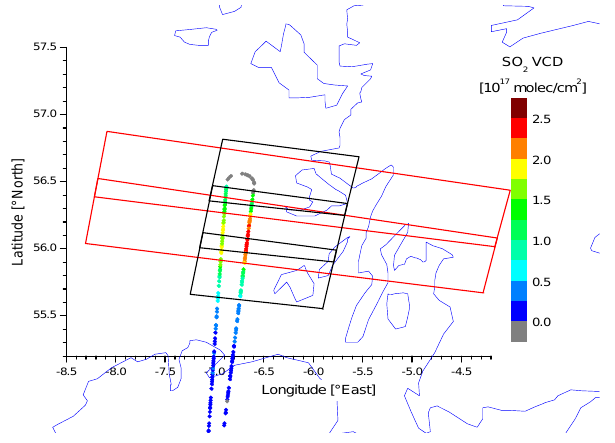
Fig. 14. SO 2 vertical column density from CARIBIC and the ob- served plume position relative to the GOME-2 pixel (black: for- ward, red: back scan). In contrast to Figure 2 only those pixels are shown that cover the volcanic plume and at least one measurement from CARIBIC, namely the pixels 21 of swath 26 (North), 27 and 28, as well as the back scan pixel 27 of swath 26 and 27. The maxi- mum of the CARIBIC DOAS SO 2 columns is perfectly covered by one back scan, moreover it is located in the overlapping area of two different forward scan pixels. For the period of the turn no AMF were calculated, therefore the VCD is grey colour coded.